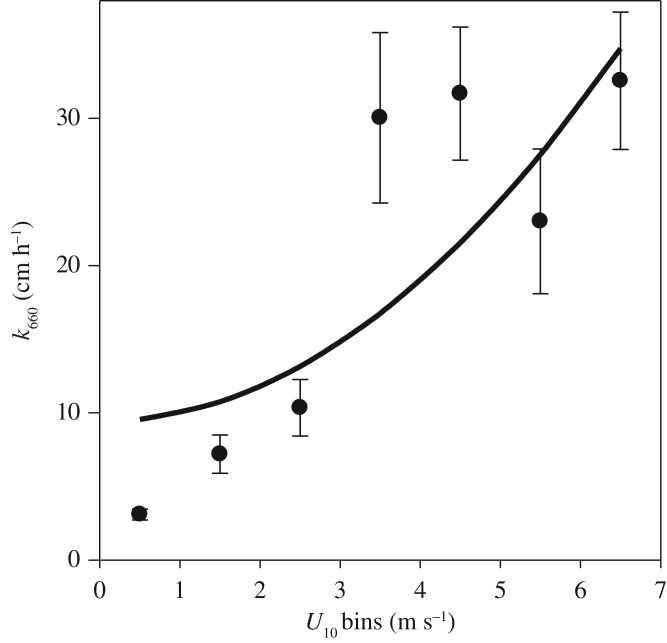
Distribution of in situ k660 versus wind bins (U10). The black dots are the average of k for each wind bin and the error bars are the standard error of the average for each wind bin. Quadratic regression of our study; k660 = 9.4 (±4.9) + 0.6 (±0.1) *U102.